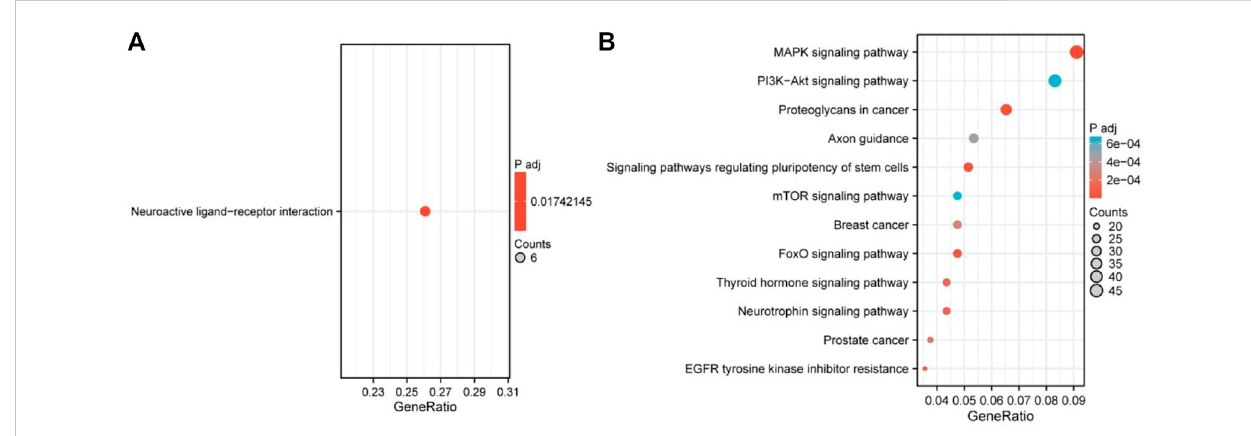
FIGURE 5 Thefunctionalenrichmentanalysisofmodule4inTNBC. (A) Theenricheditemofthe76mRNAs. (B) TheenricheditemofthemiRNA-relatedtarget genes.